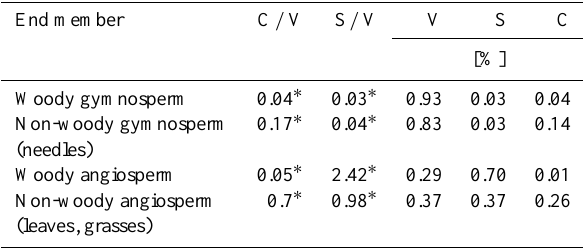
Table 6. End-member ratios taken from the literature used for the unmixing model here and our calculated relative amounts of V, S, and C phenols. For abbreviations see description in Table 4 and